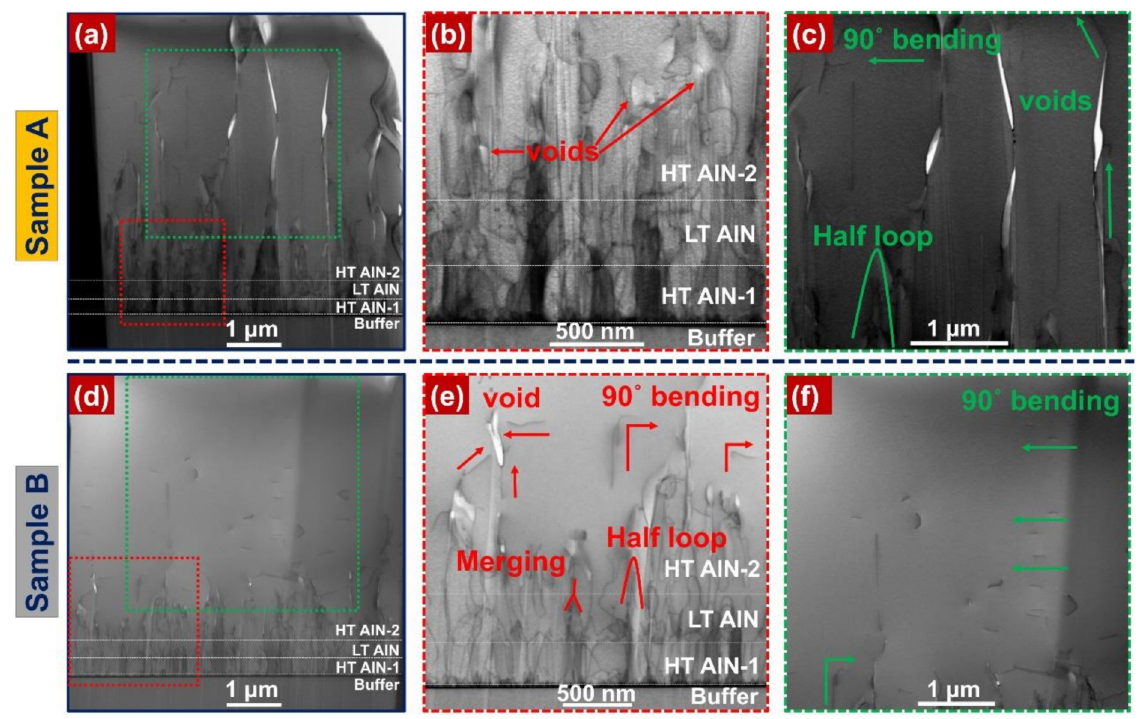
Figure 10. Cross-sectional bright-field (BF) STEM images of MSG-AlN grown on ( a – c ) MOCVD AlN buffer and ( d – f ) sputtered AlN buffer. The air voids provide sufficient free surfaces for dislocation termination. However, for the MSG-AlN grown on the MOCVD AlN buffer, lots of new dislocations are also generated on the coalescence boundaries, which is hardly observed in the MSG-AlN grown on the sputtered AlN buffer. Reprinted with permission from [17]. Copyright {2018} American Chemical